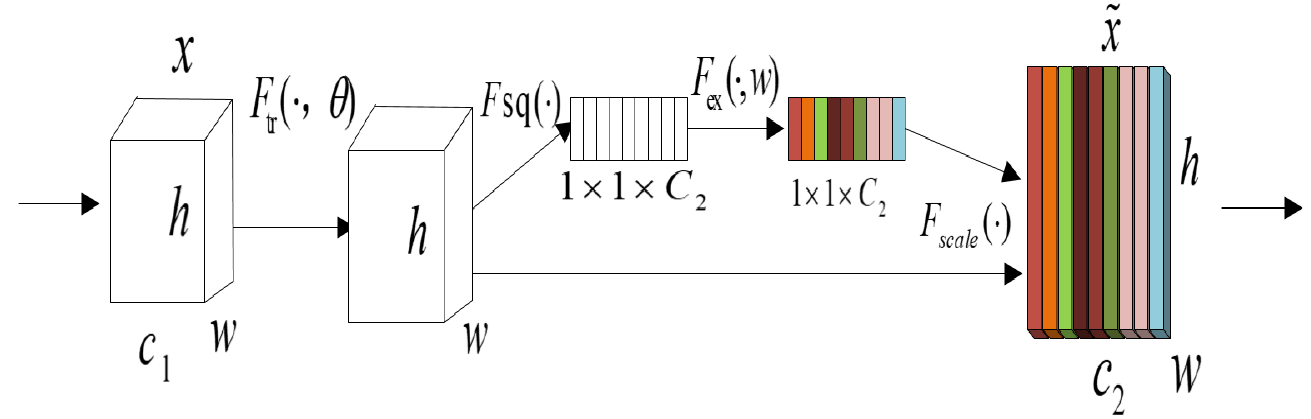
Figure 6. SE module structure diagram.